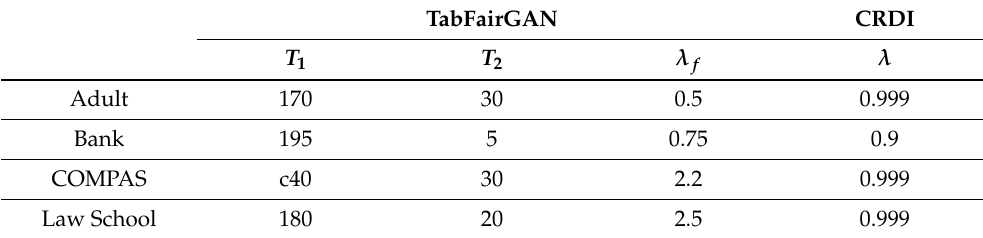
Table A1. Paramter Configuration for TabFairGAN and